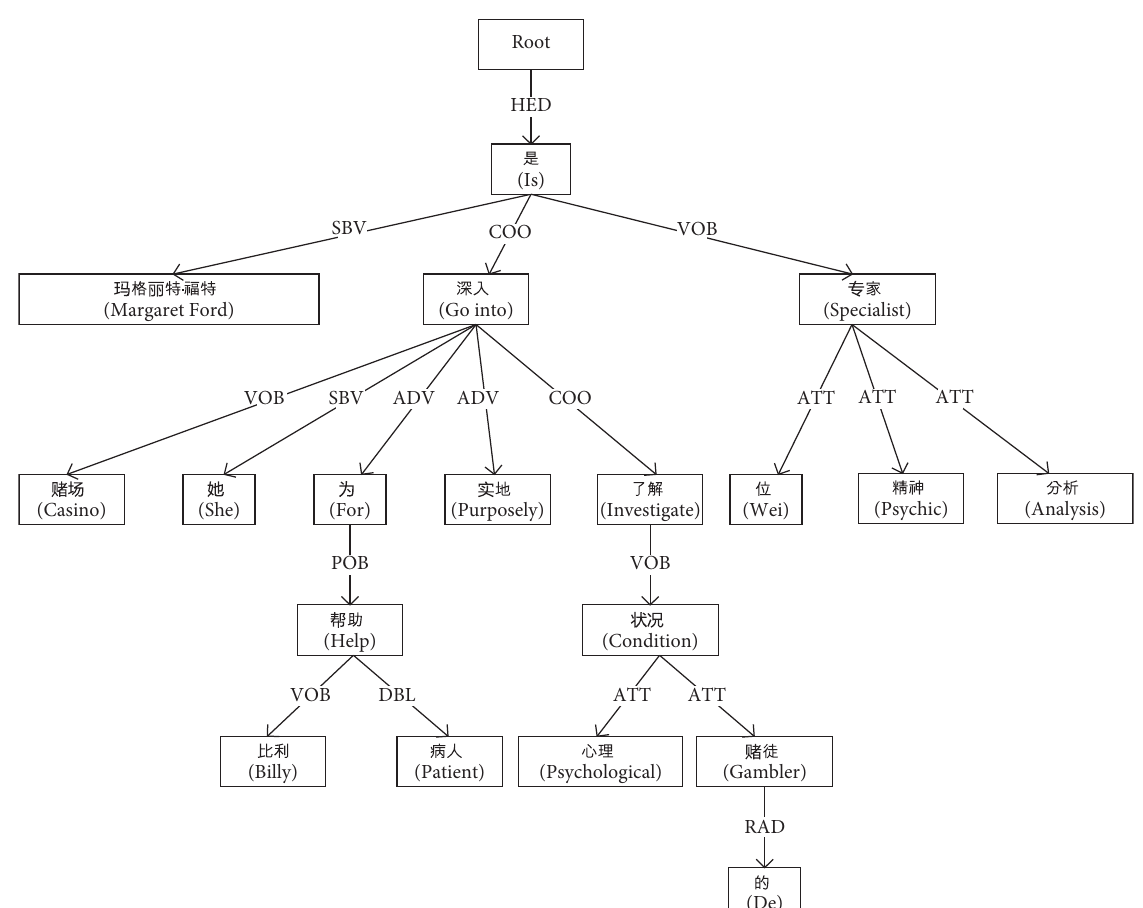
Figure 3: An example of dependency tree for an input sentence. Conventional abbreviations include the following: SBV � subject of verb; VOB � object of verb; IOB � indirect object; FOB � fronting object; DBL � double roles: subject and object; ATT � attribute; ADV � adverbial; CMP � complement; COO � coordinate; POB � preposition-object; LAD � left adjunct; RAD � right adjunct. More details about the dependency types can be found in http://ltp.readthedocs.io/zh